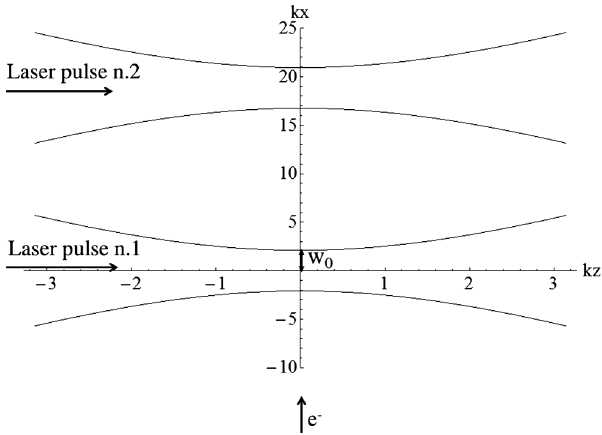
FIG. 1. A N ¼ 2 optical cell. The laser pulses propagate along the z axis and the particles are injected along x . Distances are expressed in units of λ : kz (or kx ) ¼ 2 π corresponds to a shift of λ in the z ( x ) direction. w 0 is the beam spot (see